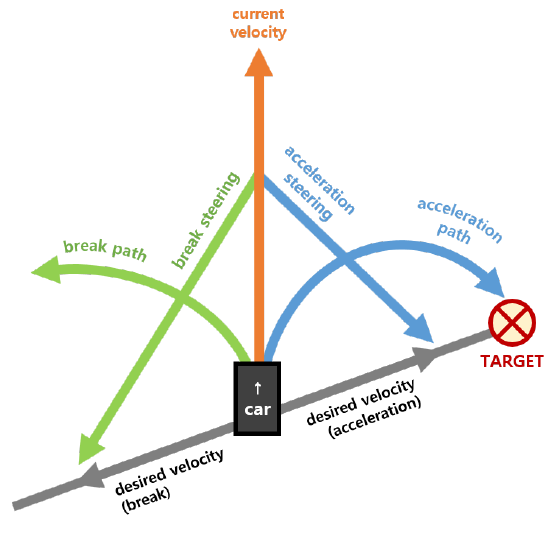
Figure 3. Steering vehicle toward target point.